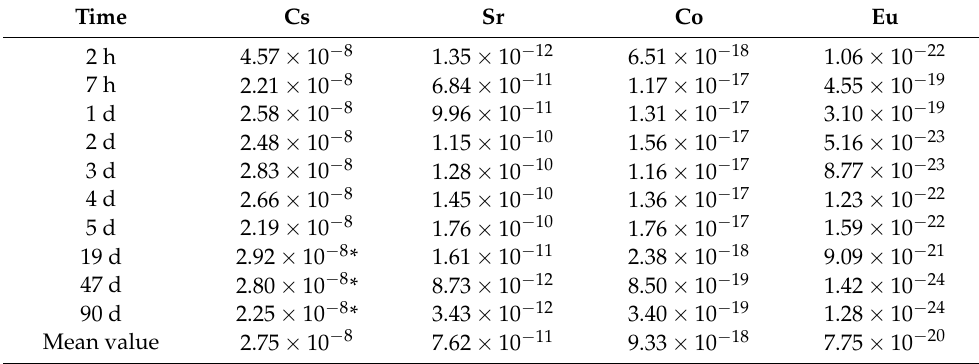
Table 3. The effective diffusion coefficients of the nuclides (Cs, Sr, Co, and Eu).